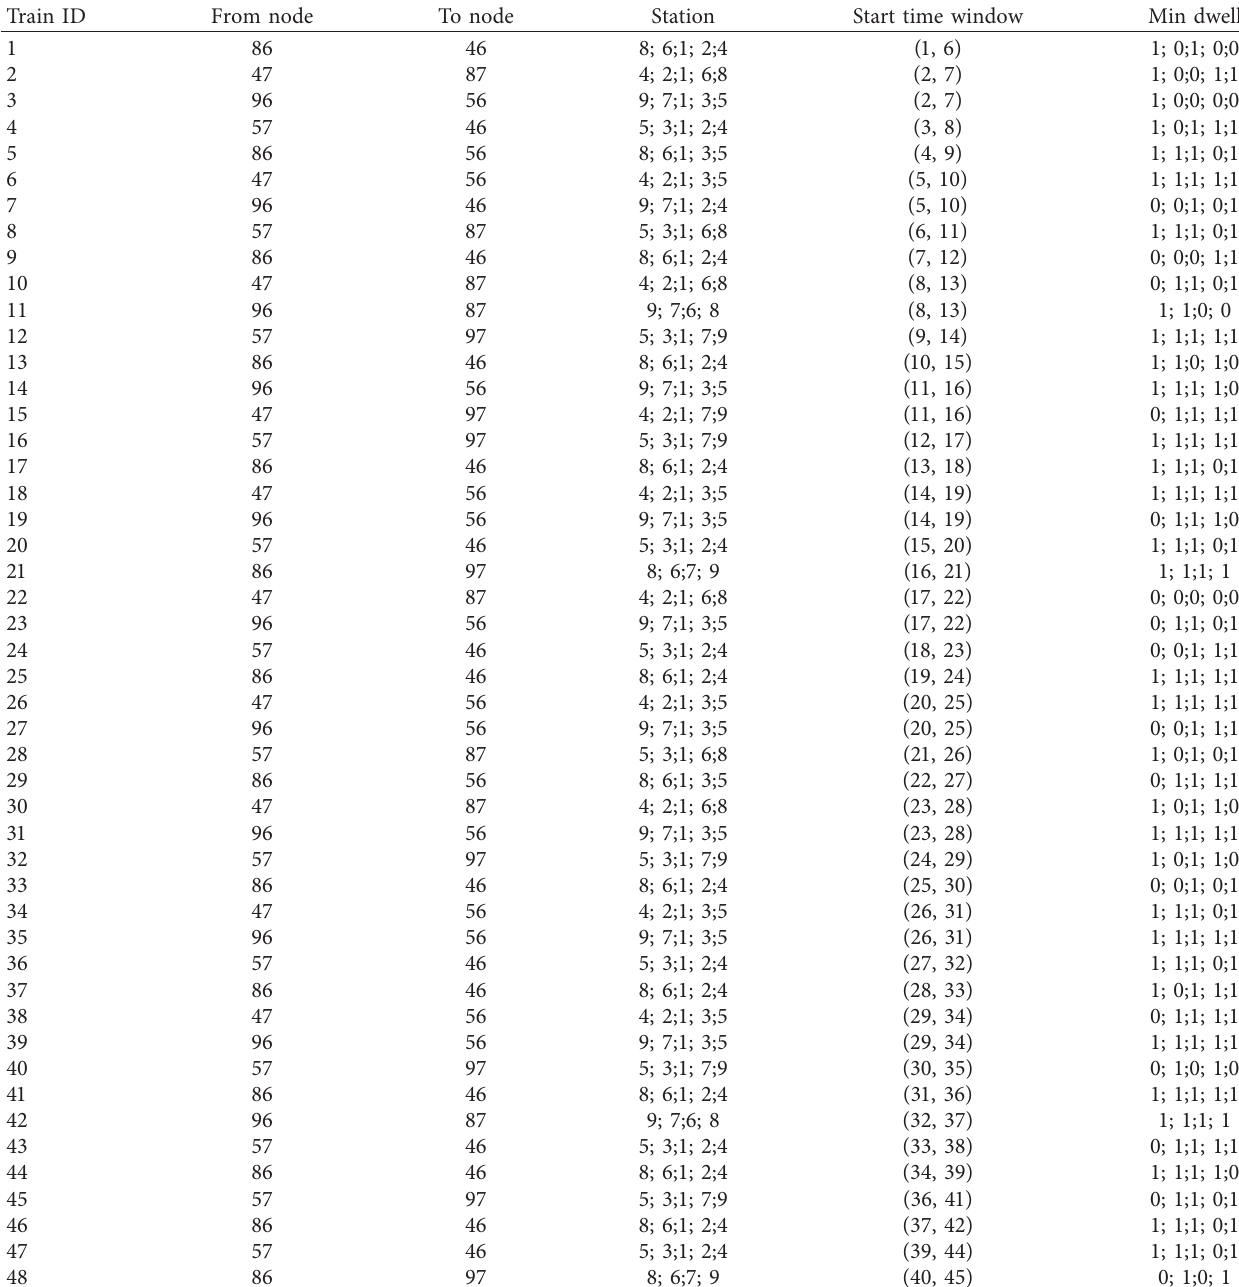
Table 8: Train data for medium-sized railway